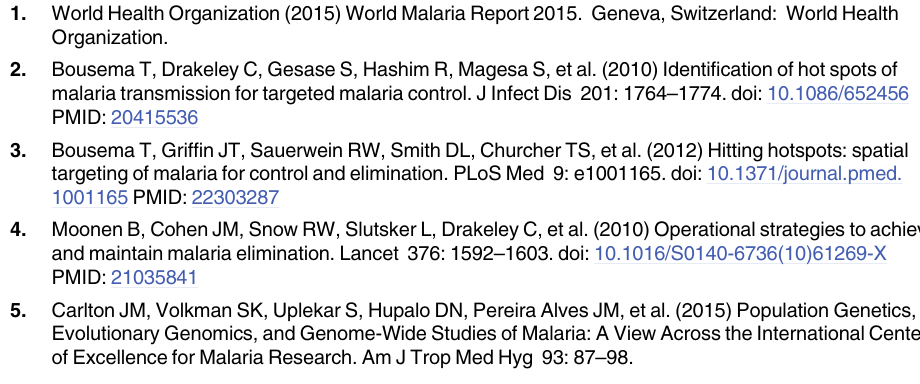
S1 Table. SNP data. S2 Table. The 95% credible intervals of COI of samples from Uganda. S3 Table. The 95% credible intervals of allele